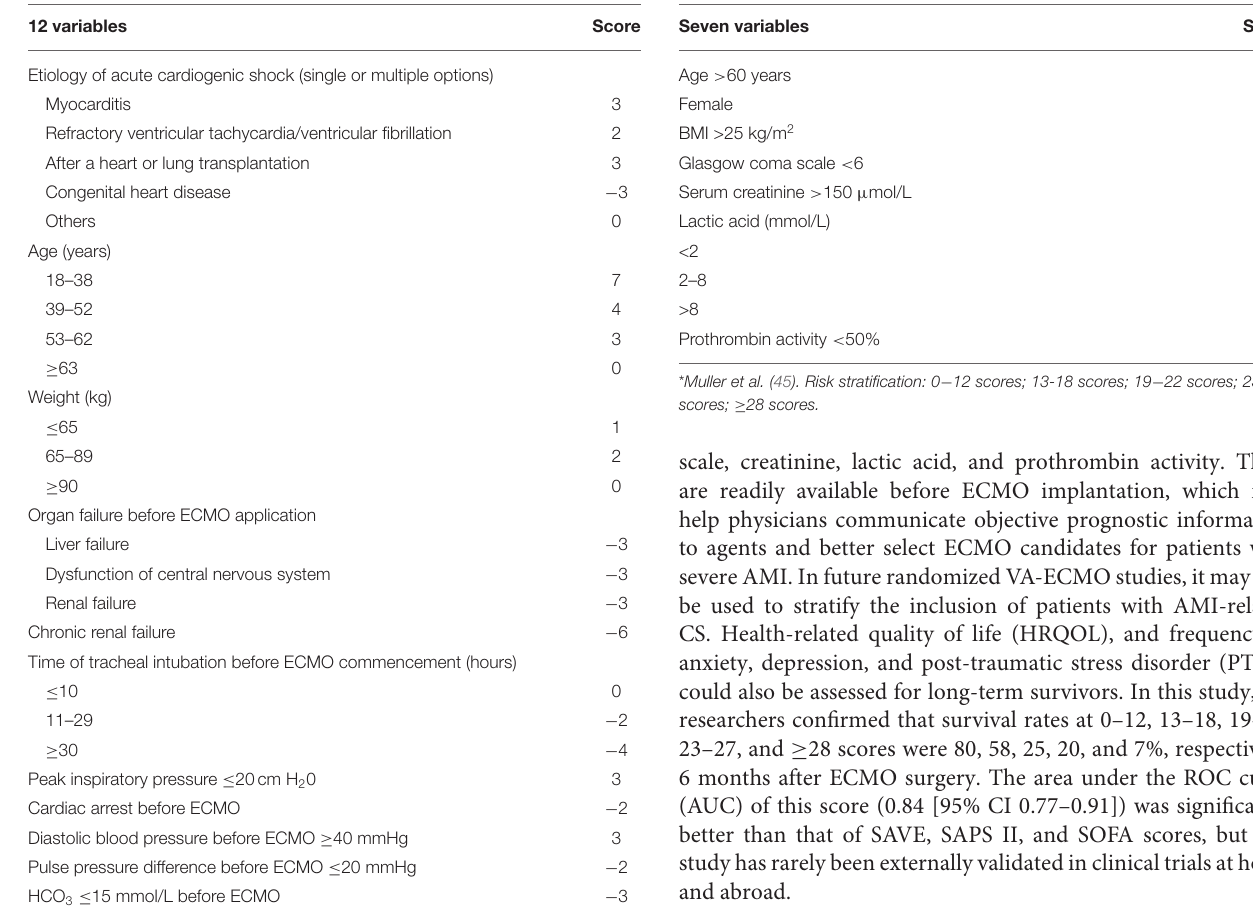
TABLE 4 | SAVE-score. TABLE 5 | The ENCOURAGE mortality risk